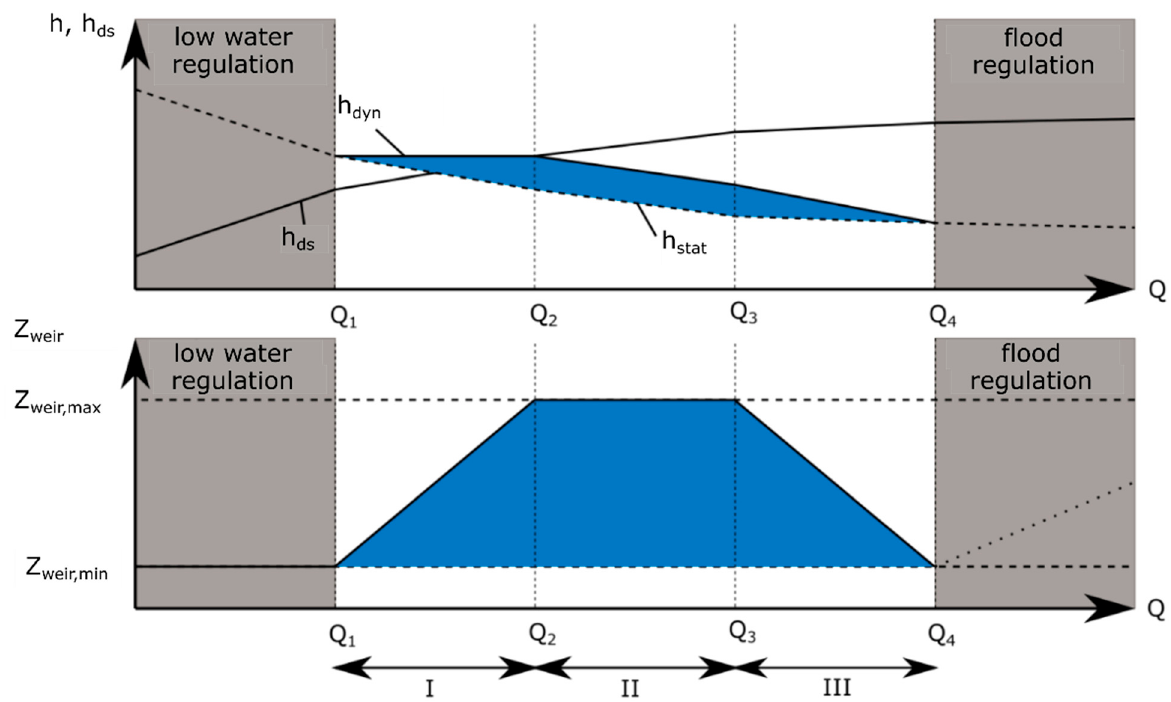
Figure 2. Schematic control and head curve for dynamic water-level regulation [8].